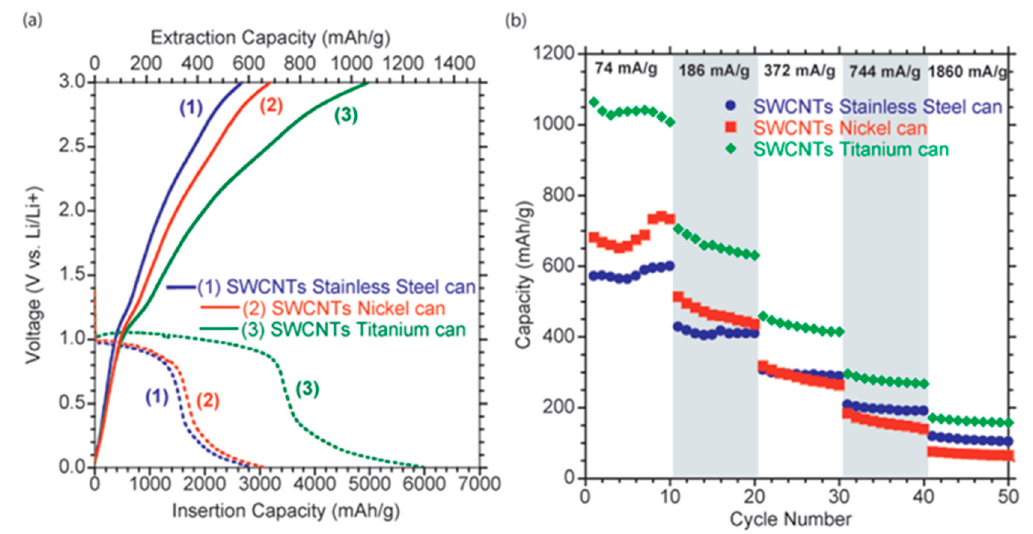
Figure 3. ( a ) Single-walled carbon nanotube (SWCNT) electrode voltage profile in extraction and initial insertion of the cycle on stainless steel. Nickel and Titanium coated cells at a current density of 74 mA g − 1 ( b ) Cycling stability of all three metal-coated cells at various current densities.